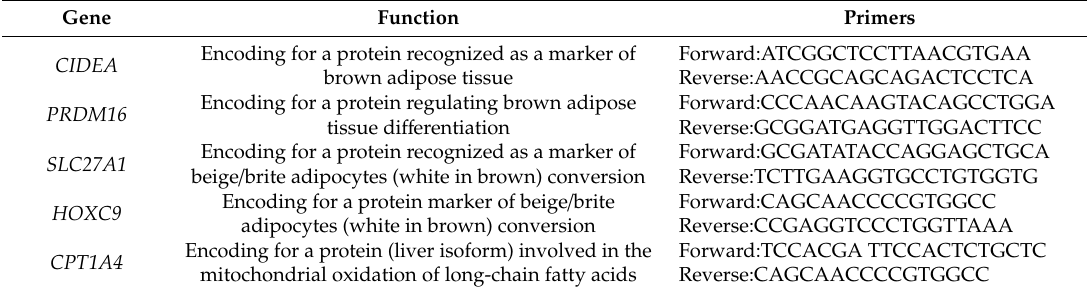
Table 1. Brown, beige, and fatty acid utilization markers under